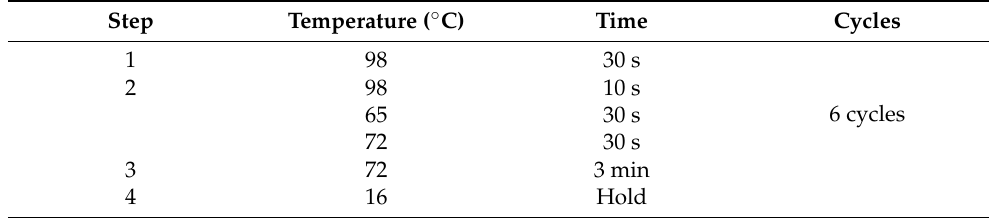
Table 11. PCR Scheme for Preamplification of cDNA.